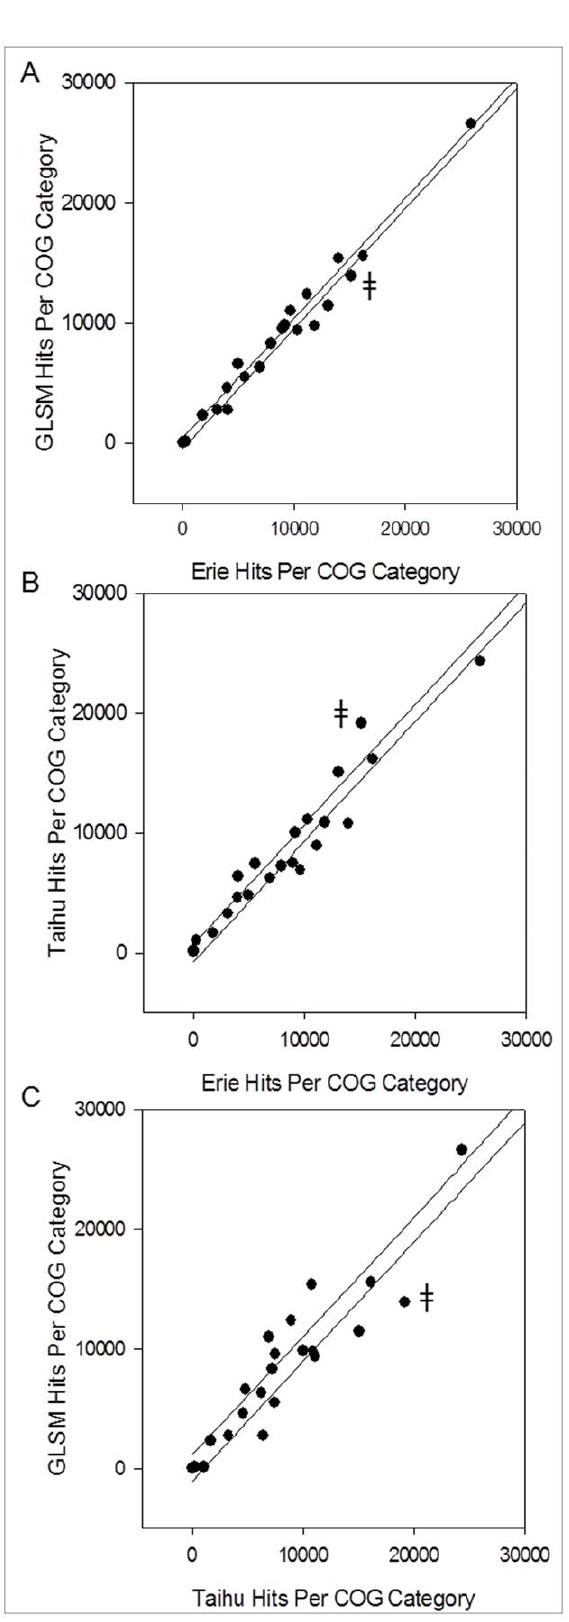
Figure 5. Comparison of number of hits to COG categories between bloom metagenomes. Normalized number of hits to each COG category from each metagenome plotted against the other.